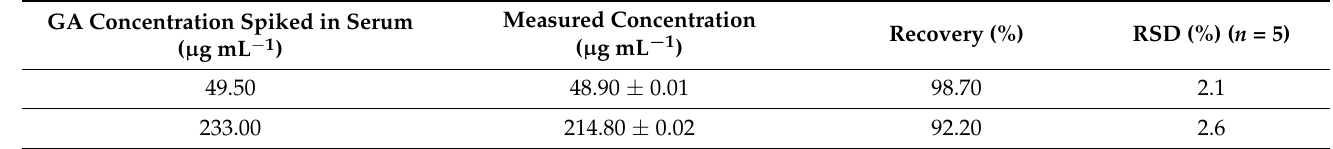
Table 2. Recovery assay of GA protein in human serum by the developed aptasensor. GA Concentration Spiked in